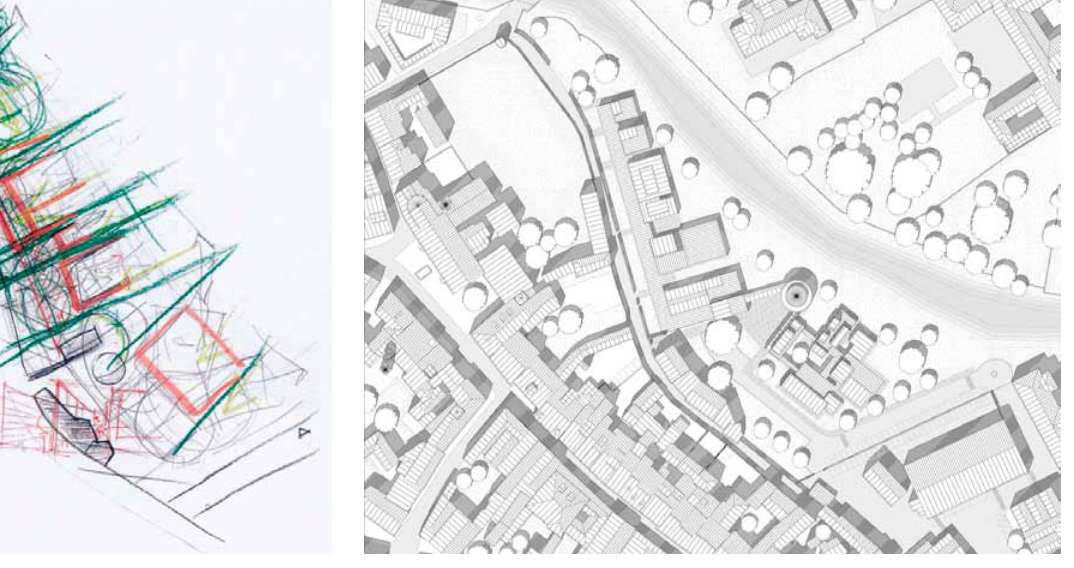
fig. 5b. Planivolumetric plan (Bellotto, Bronca